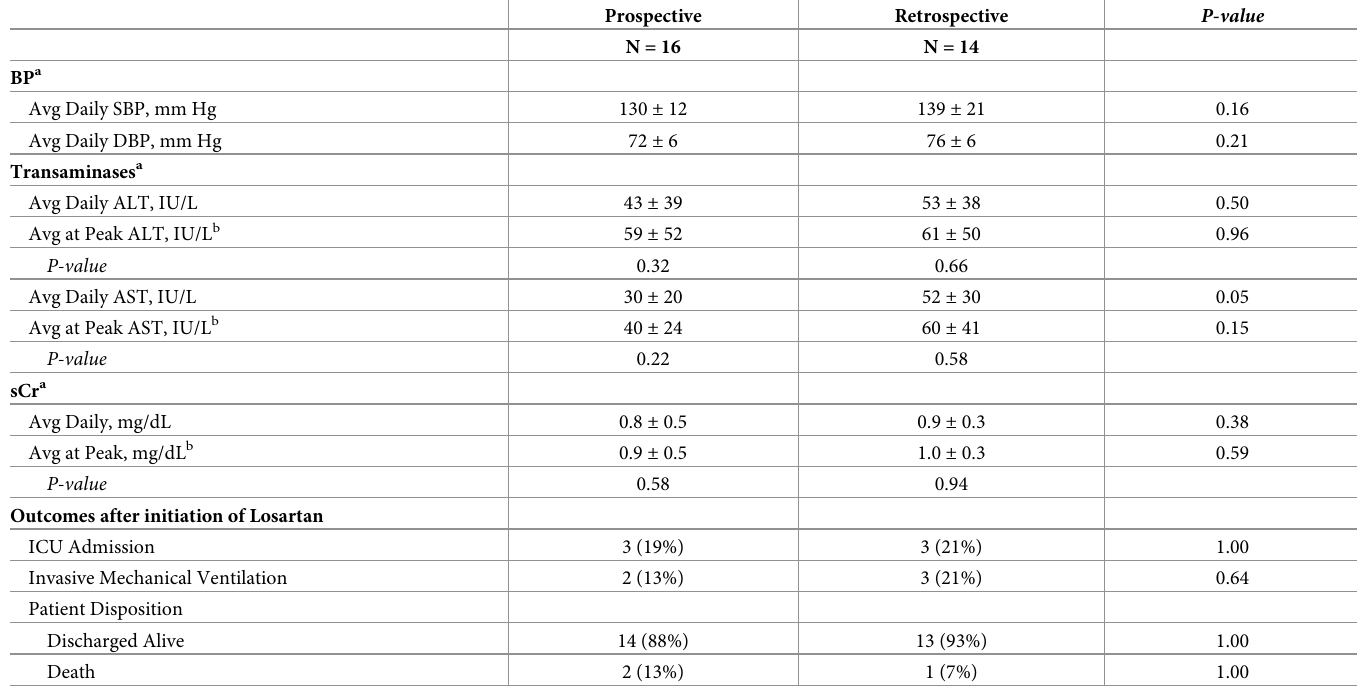
Table 4. Clinical outcomes & disposition after initiation of losartan in the study cohort.